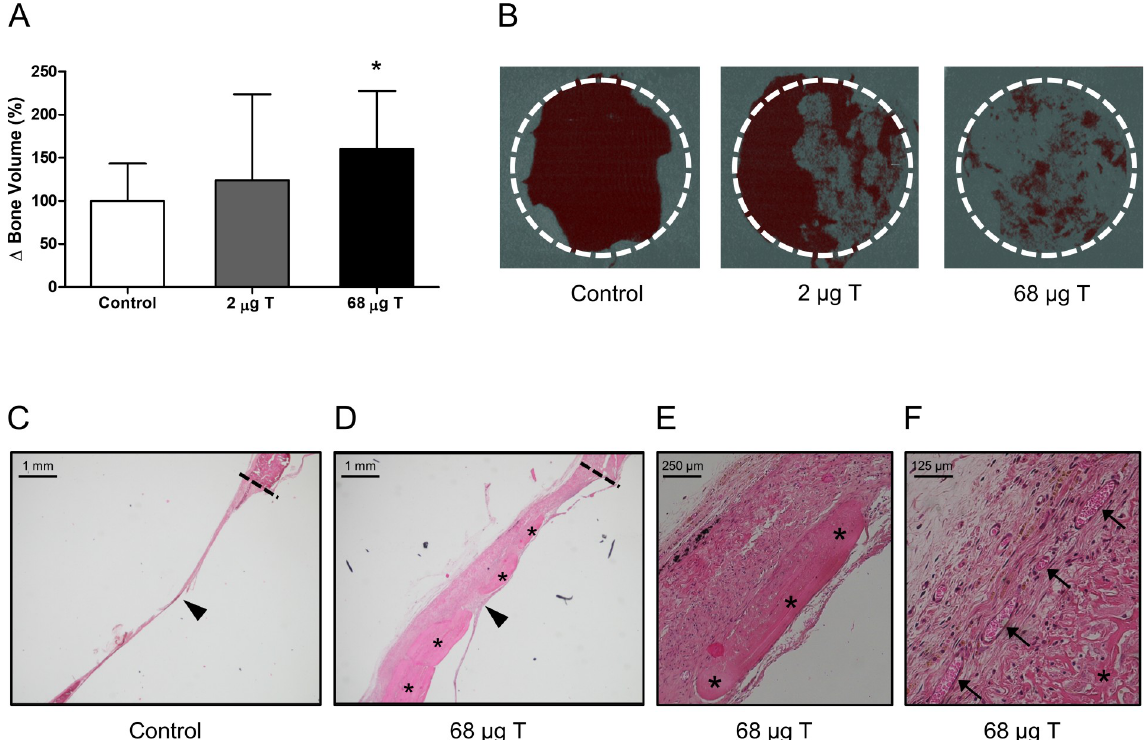
Fig 3. Rat critical size calvarial defect model. Defects covered with membranes coated with 68 μ g testosterone (T) and 20 μ g alendronate showed increased bone volume (BV) compared to controls after 8 weeks (A, n = 7–8). Two dimensional μ CT images of the defects (B) indicated different bone growth patterns for controls (mainly along the defect edge (dashed line)) and membrane covered defects (covering the defect) (B). HE-staining of sections of control defects after 11 weeks showed a thin fibrous tissue layer (arrowhead) without newly formed bone connected to the defect edge (dashed line) and covering the defect (C, 2.5x). Defects covered with a membrane coated with 68 μ g testosterone and 20 μ g alendronate after 11 weeks showed a thick fibrous layer (arrowhead) connected to the defect edge (dashed line) in which newly formed bone is visible (asterisk) (D, 2.5x). Higher magnifications show the newly formed bone in more detail (E, 10x), and the presence of blood vessels (arrows) within the fibrous layer (F, 20x). Significant differences compared to controls are indicated by asterisks: � p �